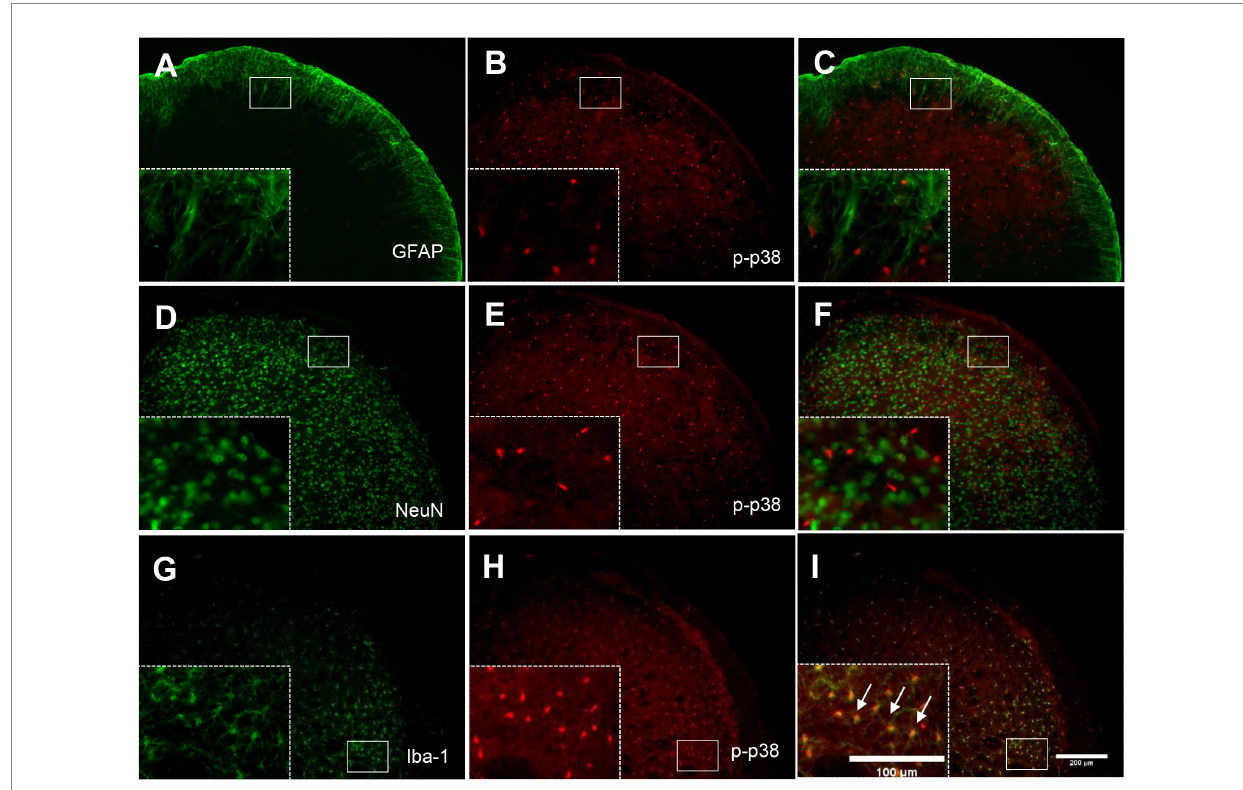
FIGURE 7 Colocalization of GFAP, NeuN, or Iba-1 with p-p38 in the TNC. Neither GFAP (A–C) nor NeuN (D–F) was colocalized with p-p38 in the TNC. In contrast, Iba-1 immunoreactivity was visualized in p-p38-positive cells in the TNC of the ION-pNL group (G–I) . The rectangular areas are magnified from each panel (A–I) and arrows indicate representative p-p38-immunoreactive cells contained for Iba-1. Scale bar = 200 μ m, 100 μ m in enlarged